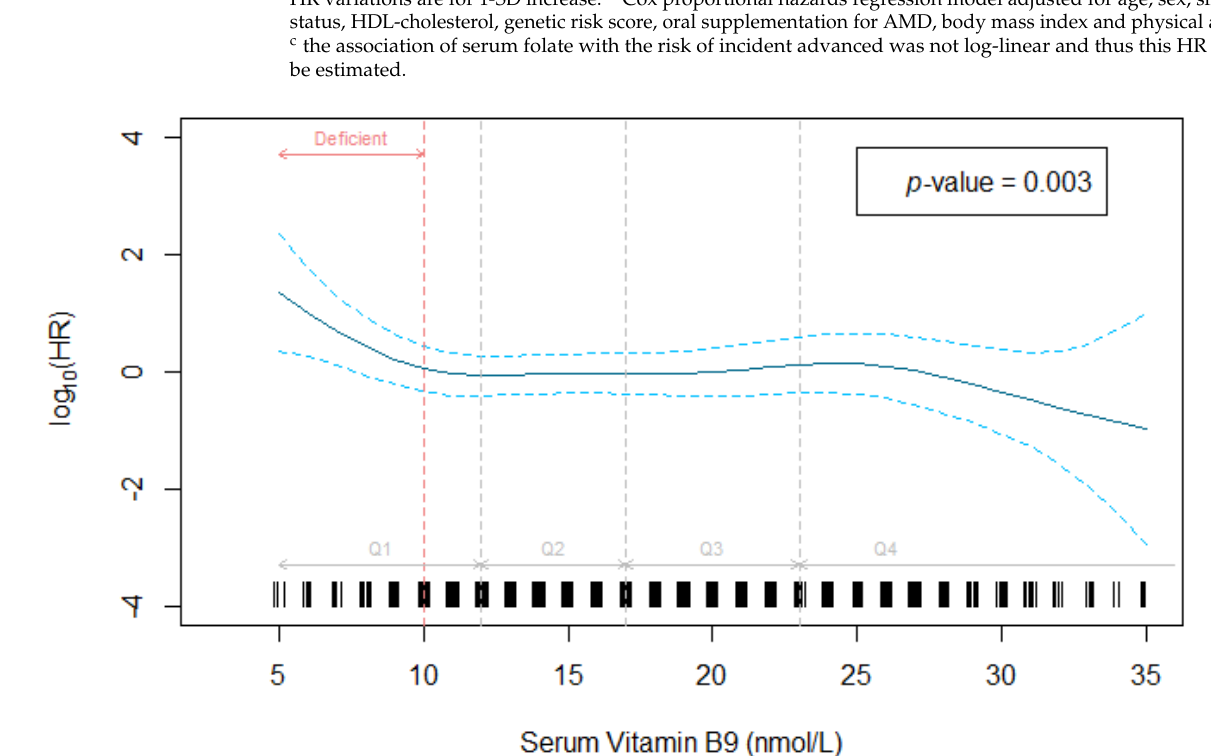
Figure 1. Association between serum folate and incidence of advanced AMD adjusted for age, sex, smoking status, HDL-cholesterol, genetic risk score, oral supplementation for AMD, body mass index and physical activity. Data from the Alienor Study 2001–2017 ( n = 654). Serum folate was modeled using p-spline with 4 degrees of freedom in the Cox model. HR: hazard ratio.